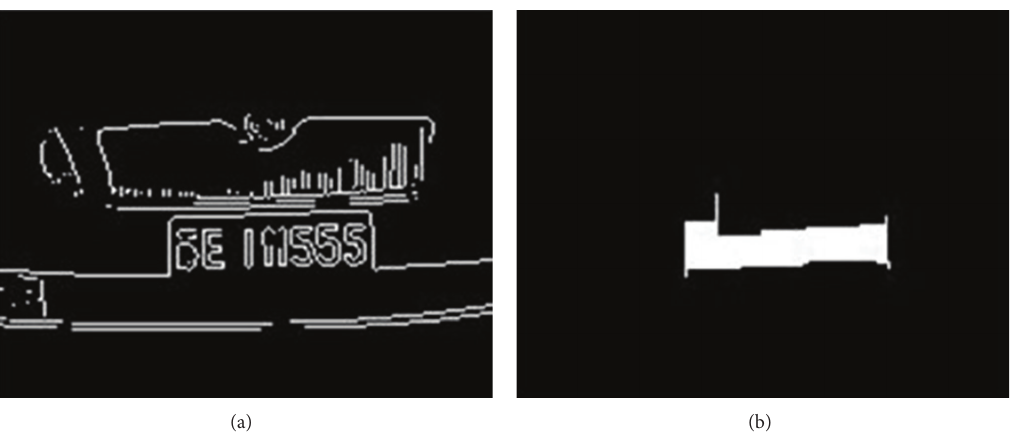
Figure 13: (a) Edge extraction. (b) Morphological image.